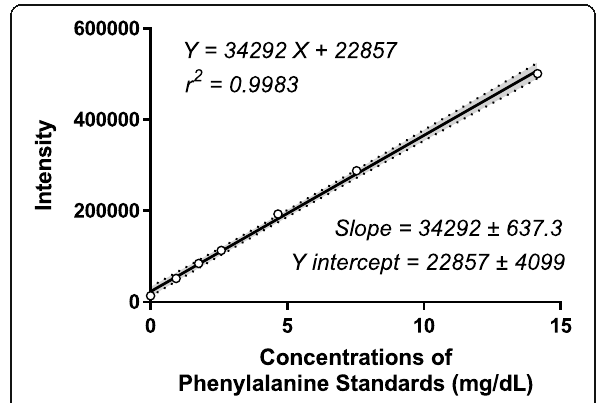
Fig. 3 Calibration curve for estimating phenylalanine concentration in dried blood spots. The shaded area between the lower and upper dotted lines represents the 95% CI of the curve, showing the equation and coefficient of determination ( r 2 ). Slope and Y intercept are reported as mean ±